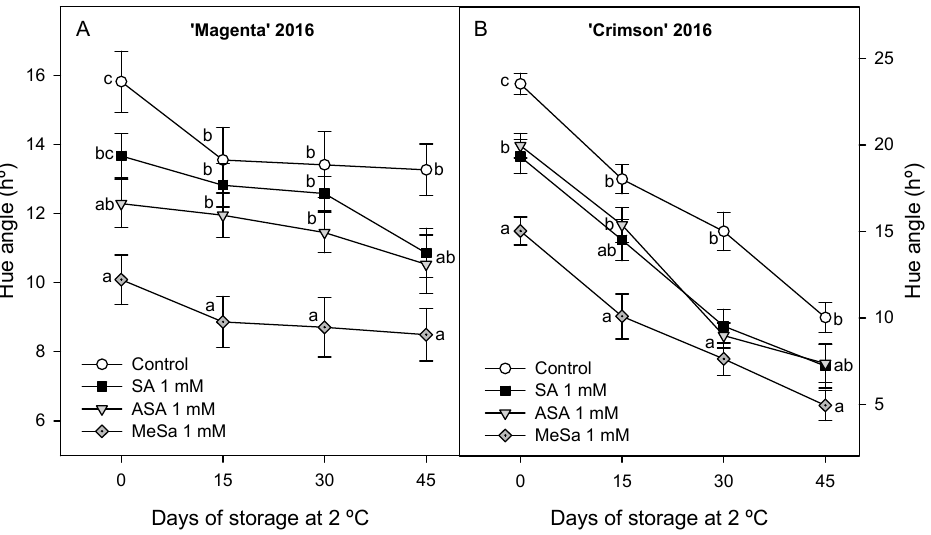
Figure 6. Effects of preharvest 1 mM salicylic acid (SA), acetyl salicylic acid (ASA) and methyl salicylate (MeSa) treatments on Hue angle colour evolution of ‘Magenta’ ( A ) and ‘Crimson’ ( B ) table grapes during storage at 2 ° C in 2016 experiment. Data are the mean ± SE of measures made on 30 berries for each of the three replicates. Different letters show significant differences ( p < 0.05) among treatments for each sampling date. Table 2. Total soluble solids (g · kg − 1 ) at harvest (Day 0) and after 45 days of storage at 2 ◦ C (Day 45) in ‘Magenta’ and ‘Crimson’ table grapes as a ff ected by preharvest salicylic acid (SA), acetyl salicylic acid (ASA) and methyl salicylate (MeSa) treatments in 2016 and 2017